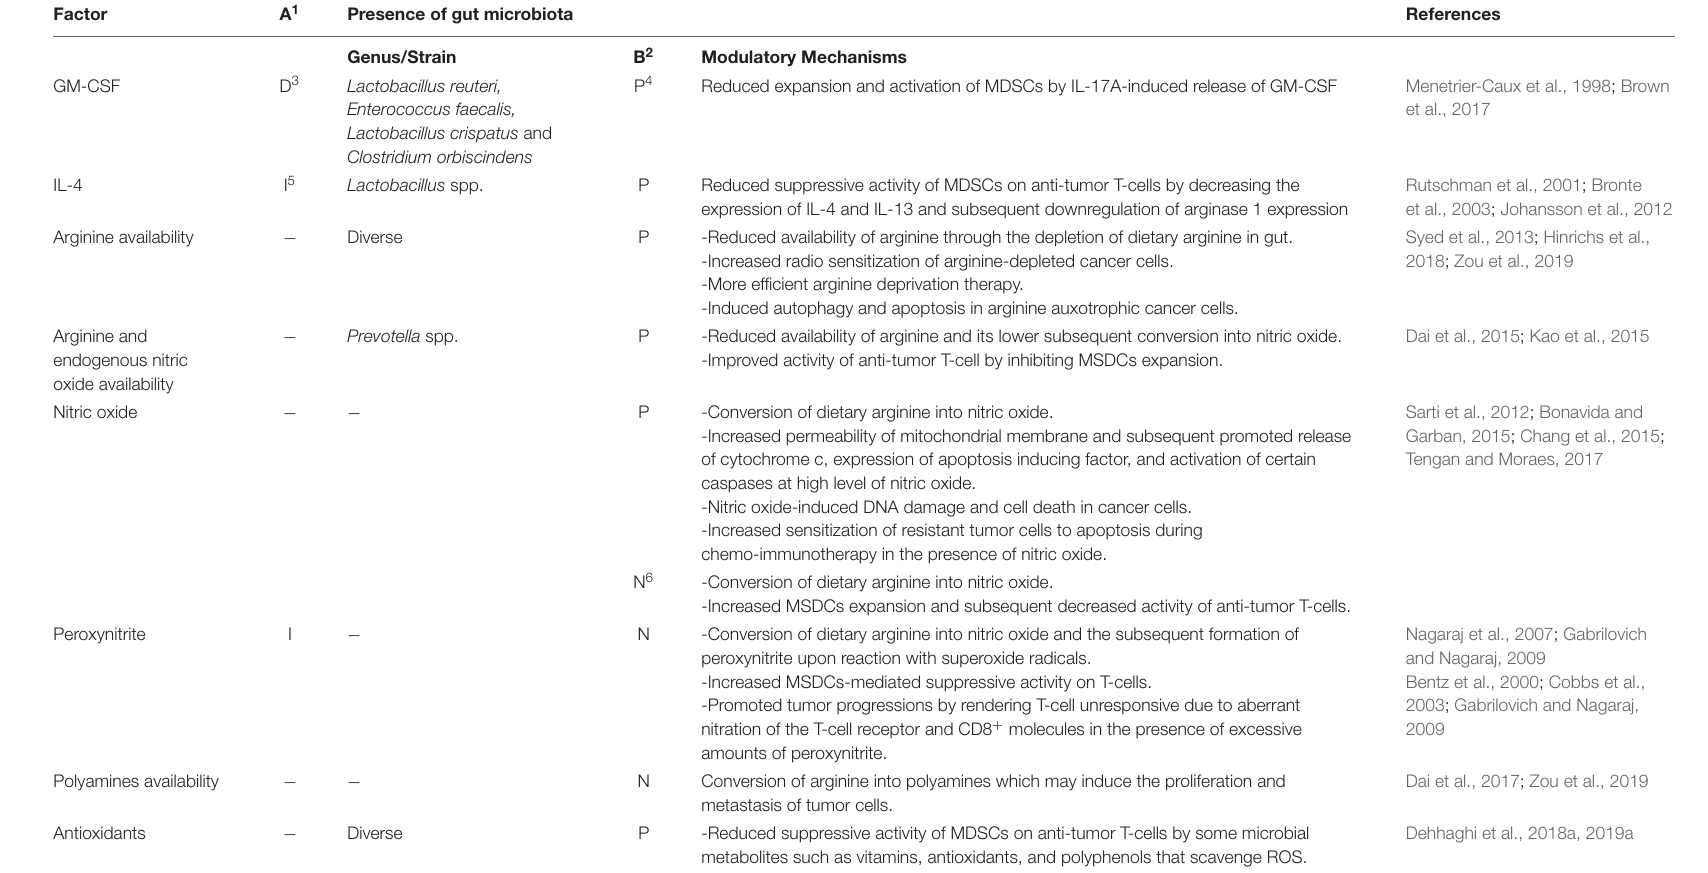
TABLE 1 | Some important factors in cancer that are affected by gut microbiota. Factor A